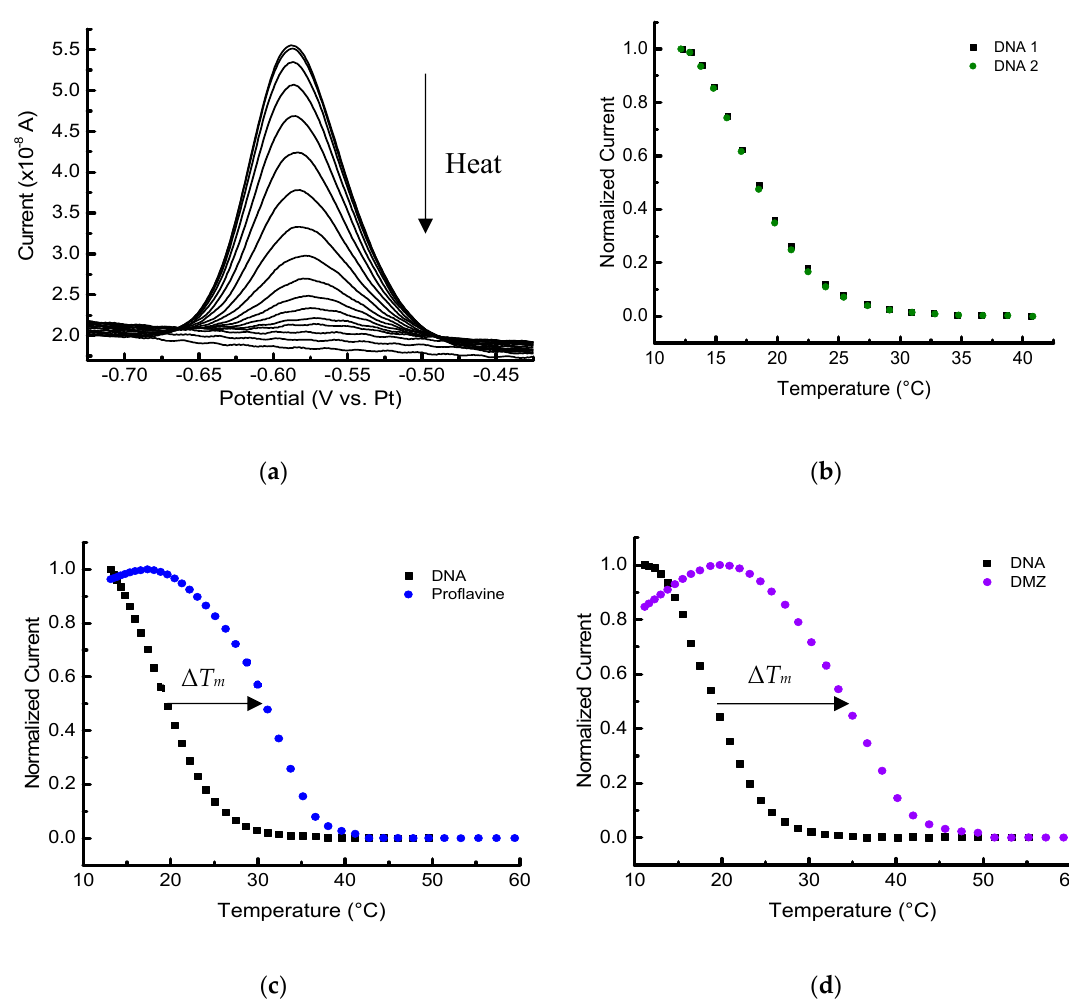
Figure 6. Melting-curve analysis of duplex DNA in the presence / absence of binding ligands performed with a thermoelectric module. ( a ) Square wave voltammograms of 2 µ mol / L MB-labeled DNA duplex in 10 mmol / L PBS with 100 mmol / L NaCl, pH 7.4. Melting curves (normalized) of duplex in the absence ( b ) and presence of 13 µ mol / L ligands: proflavine ( c ), and diminazene aceturate (DMZ) ( d ). ( b – d ) The first baseline curve is shown in black, and the second melting analysis with or without ligand is shown in its respective color.